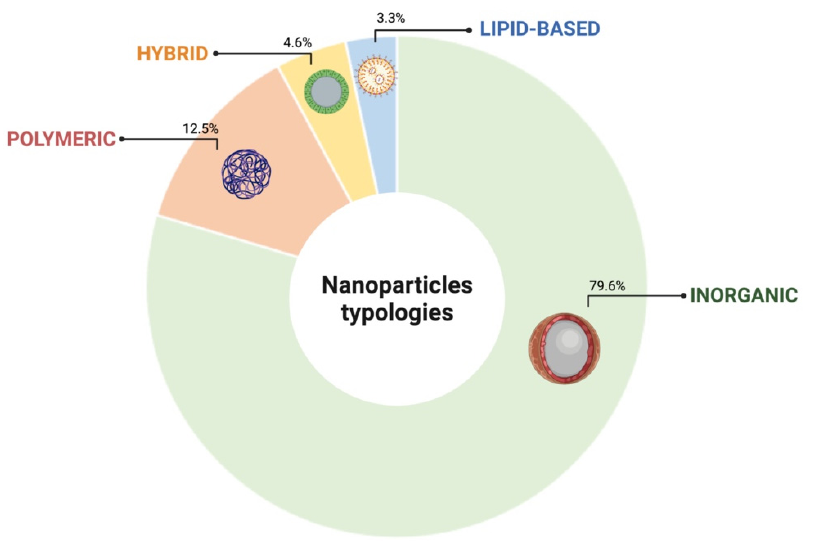
Figure 3. Classification of NPs based on the constitutive element. Classes and subclasses of nano- particles based on their chemical properties (inorganic, polymeric, hybrid and lipid-based). Percentage (%) refers to the typology of NPs with respect to the total number of NPs identified in the literature survey. Figure created with BioRender. Available online: https://biorender.com/ (accessed on 25 March 2022).